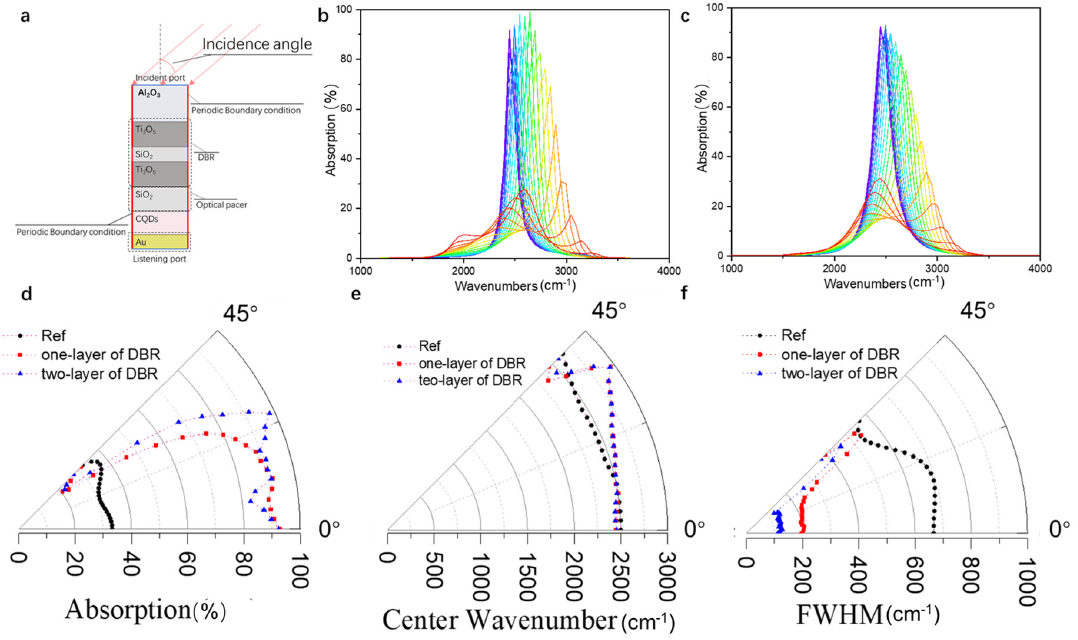
Figure 6. Influence of incidence angle on mincrospectrometer performance. ( a ) Simulation model of a CQD microspectrometer with an incident angle. Absorption of a CQD microspectrometer with different incident angles in one layer of DBR ( b ) and two layers of DBR ( c ). Absorption ( d ), center wavenumber ( e ), and FWHW ( f ) of absorption peak of the CQD detector in the range of incident angle of 0–45 degrees with one layer (red line), two layers (blue line) of DBR, and no DBR (black line).